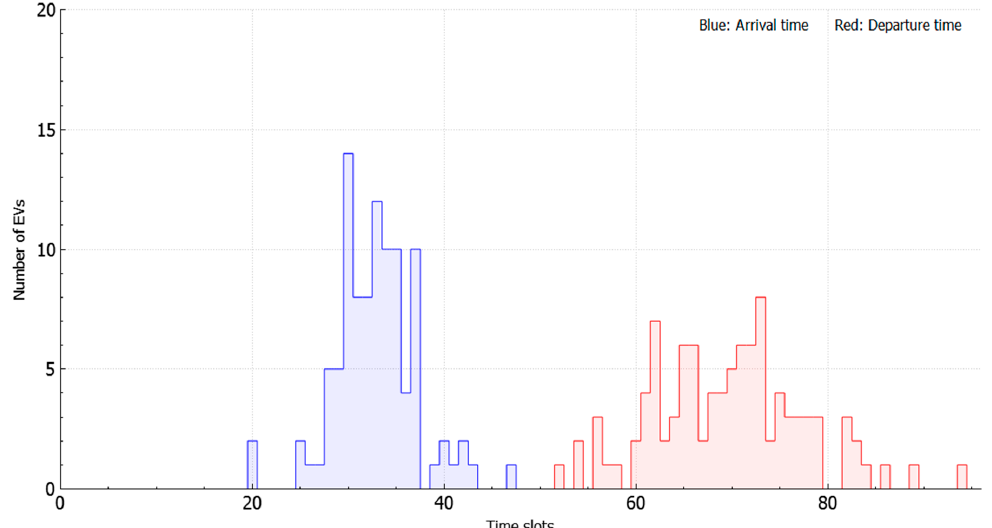
Figure 3. Arrival and departure time of 100 electric vehicles (EVs) at the university parking lot.